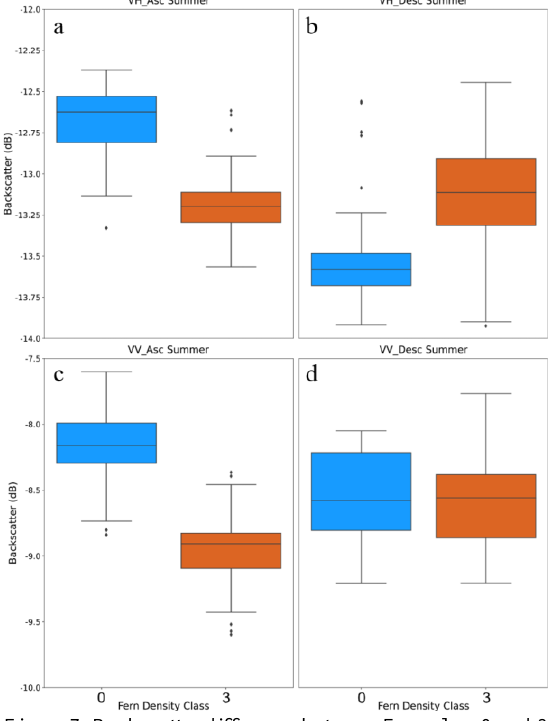
Figure 7: Backscatter difference between Fern class 0 and 3 during summer for all acquisition